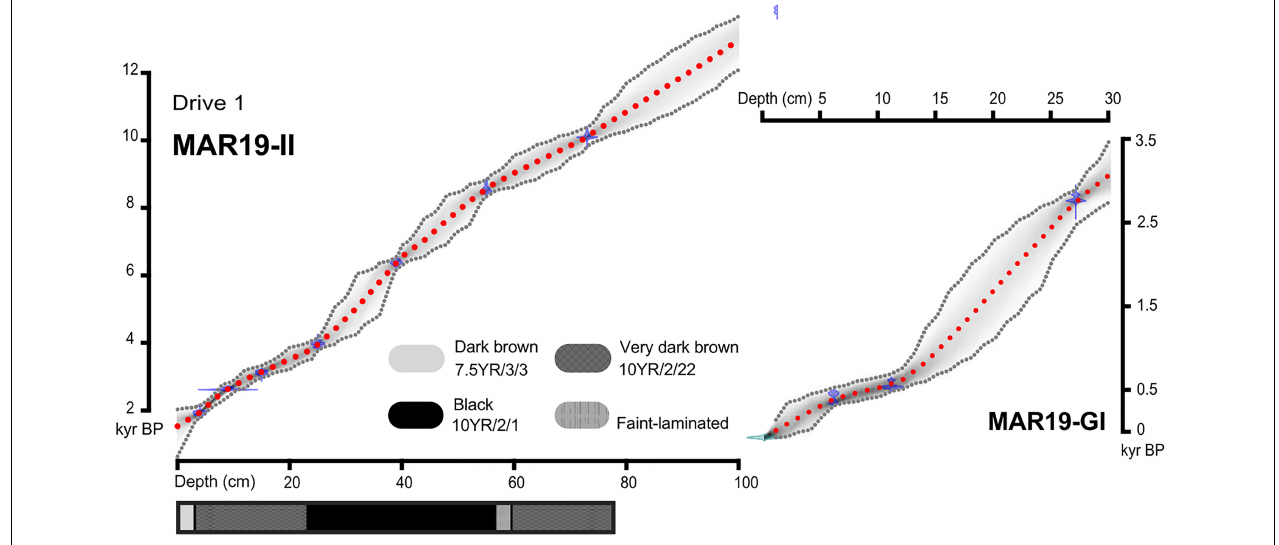
FIGURE 2 | Age-depth model for cores MAR19-II and MAR19-G1 from Monquentiva calculated using rbacon (Blaauw and Christeny, 2011) and showing: calibrated radiocarbon ages (blue bows), all likely age-depth models (gray gradient); 95% confidence intervals (gray dotted lines), and the accepted model (red dotted